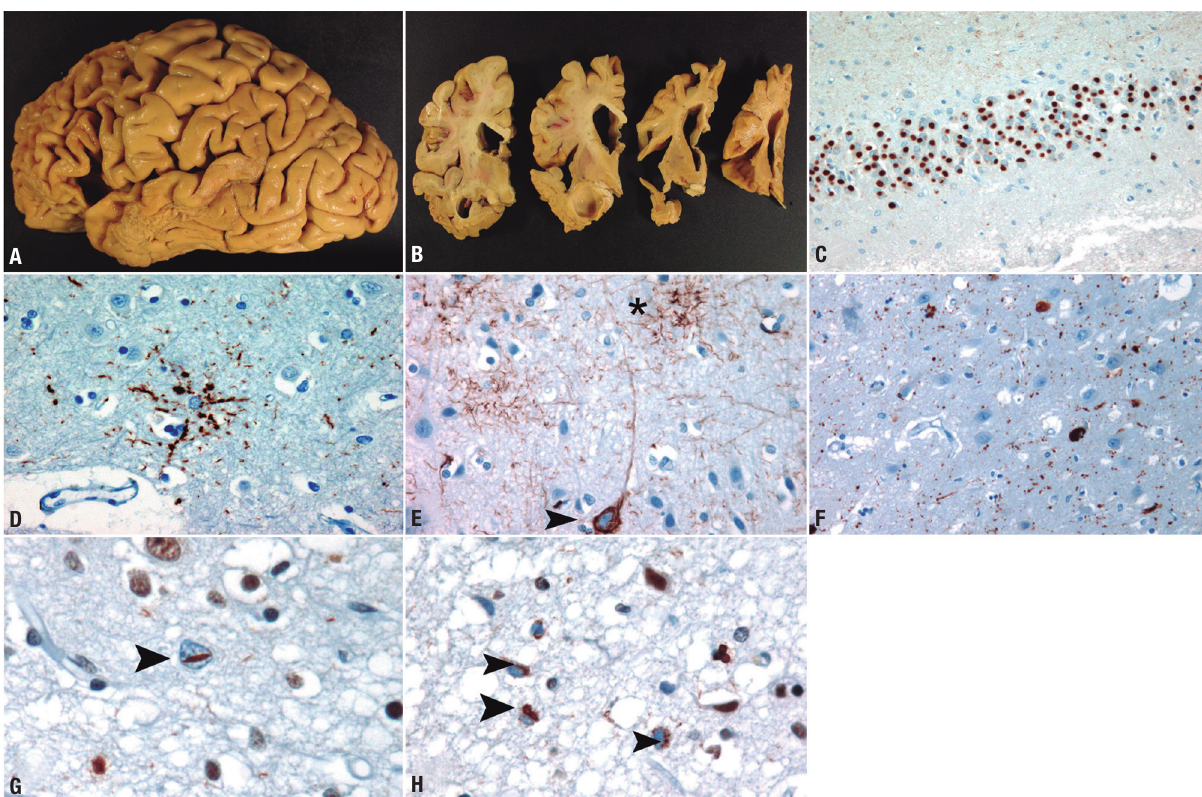
Figure 1. [A and B] Typical frontotemporal atrophy in a case of Pick’s disease. [C] Pick bodies in dentate neurons of the hippocampus (Tau immunochemistry). [D] Astrocytic plaque in a CBD case (frontal cortex, Tau immunochemistry). [E] Tufted astrocyte (asterisk) and neurofibrillary tangle in a case of PSP (primary motor cortex,Tau immunochemistry). [F] Grains and neurofibrillary tangles in a case of AGD (hippocampus, Tau immunochemistry). [G] Lentiform neuronal intra- nuclear inclusion in a case of FTLD-TDP type A (asterisk, frontal cortex, TDP-43 immunochemistry). [H] Neuronal cytoplasmic inclusions in a case of FTLD-TDP type B (arrowheads, primary motor cortex, TDP-43